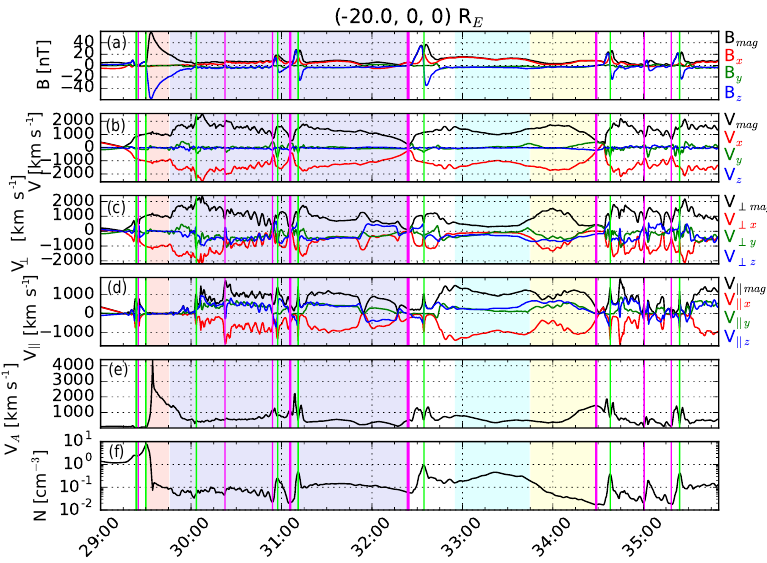
Figure 12. The same as Fig. 11 except for a satellite located at x = − 20 R E . The pink shading (29:30–29:46) indicates the plasmoid and the lavender shading (29:46–32:25) fast tailward flows following the plasmoid. The cyan shading (32:55–33:45) and yellow shading (33:45– 34:30) have the same meaning as in Fig. 11. Note that the time axis is different from the previous